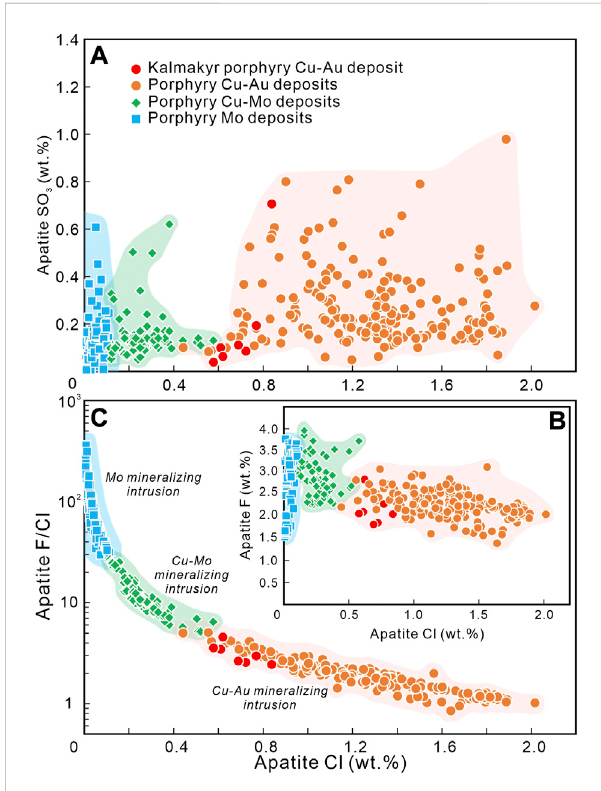
FIGURE 9 Plots of SO 3 vs . Cl (A) , F vs . Cl (B) , and F/Cl vs . Cl (C) in apatite of the Kalmakyr deposit and other porphyry deposits of the world. Data for porphyry Cu - Au deposits are from Richards et al. (2017) and Zhu et al. (2018); data for porphyry Cu - Mo deposits are from Xu et al. (2021); and data for porphyry Mo deposits are from Xing et al. (2020) and Xing et al.